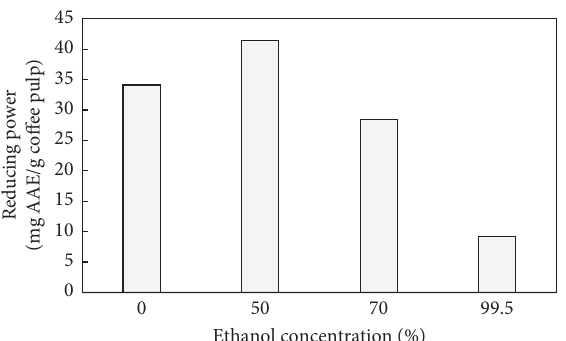
Figure 6: Reductive capacity of the coffee pulp extracts obtained using different ethanol